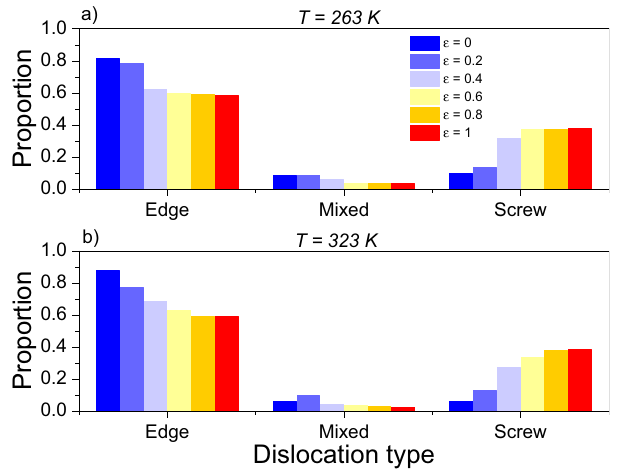
Fig. 4 Strain- and temperature-dependent fractions of dislocation types. As strain is increased during simulations at both a 263K and b 323K, a number of edge dislocations rotate towards a screw con fi guration and the system eventually stabilizes to a proportion of roughly 40% screw, 60% edge dislocations, and a near-insigni fi cant proportion of mixed